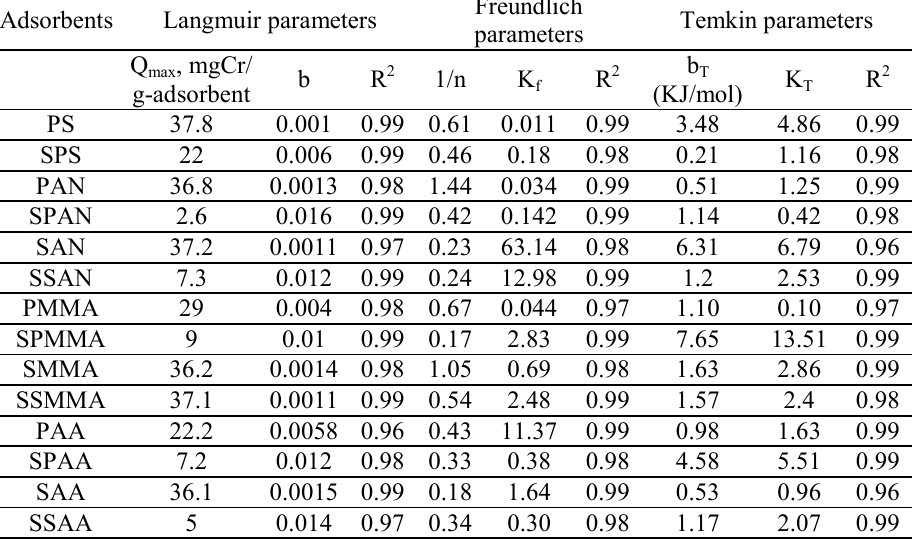
Table 1. Langmuir, Freundlich and Temkin adsorption isotherm